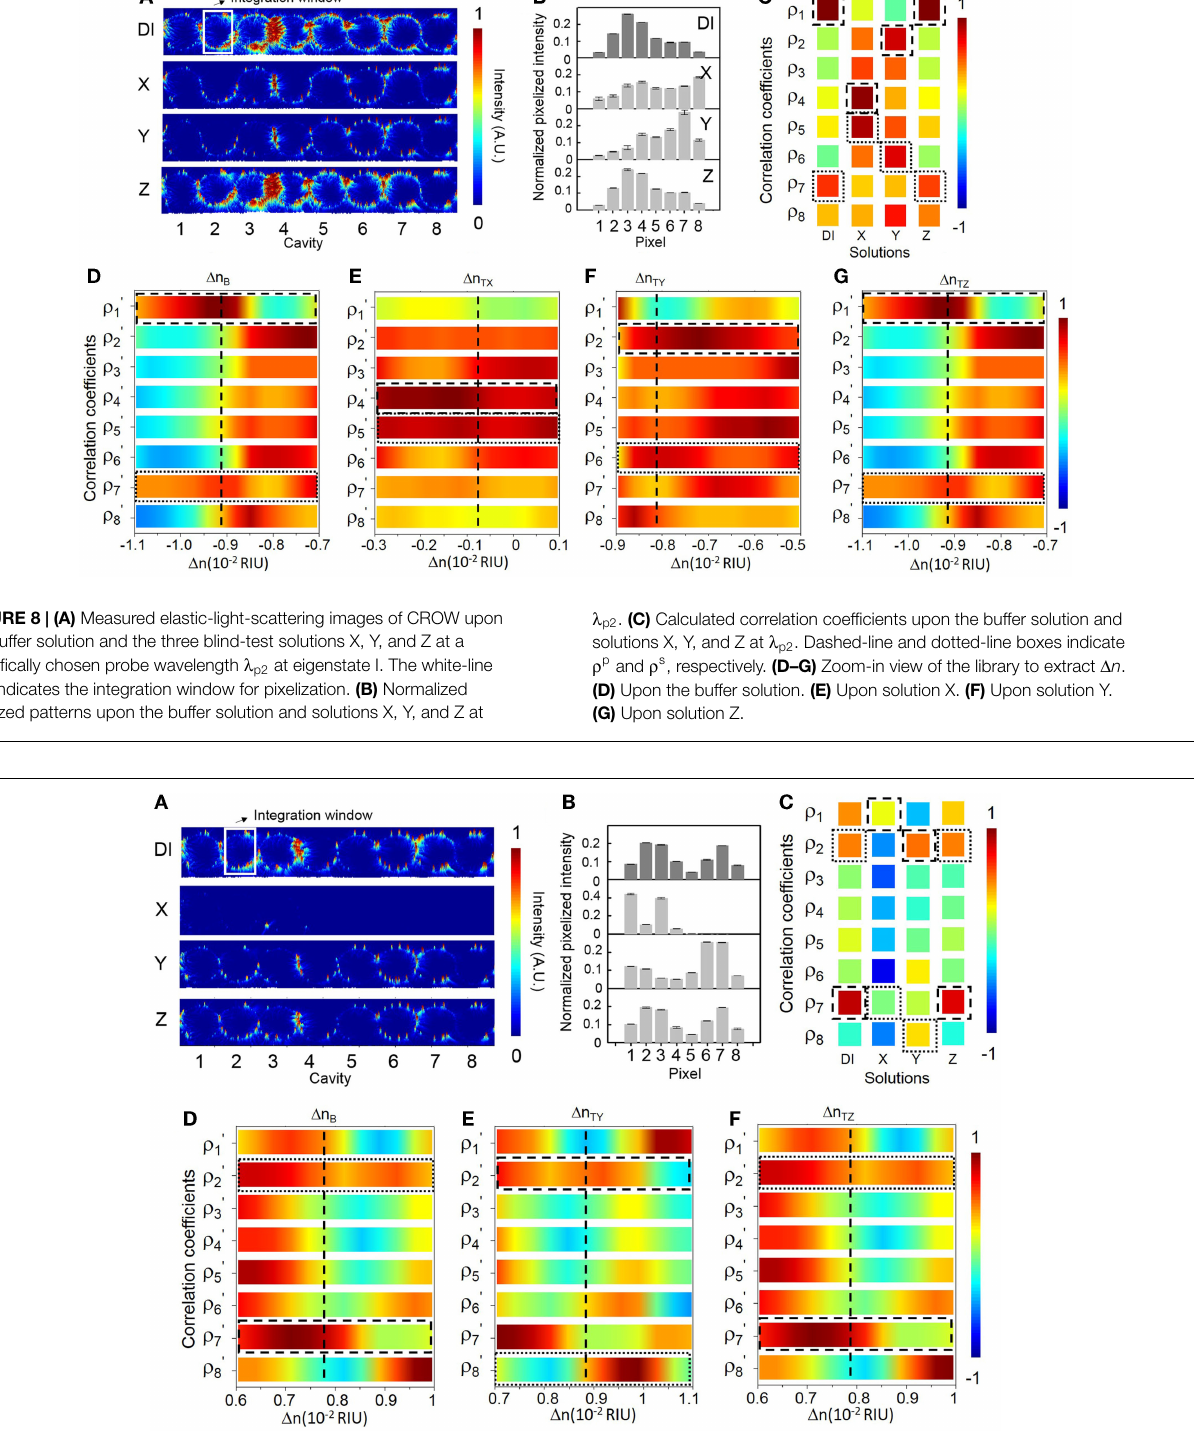
FIGURE 9 | (A) Measured elastic-light-scattering images of CROW upon the buffer solution and the three blind-test solutions X, Y, and Z at a specifically chosen probe wavelength λ p3 near eigenstate VII. The white-line box indicates the integration window for pixelization. (B) Normalized pixelized patterns upon the buffer solution and solutions X,